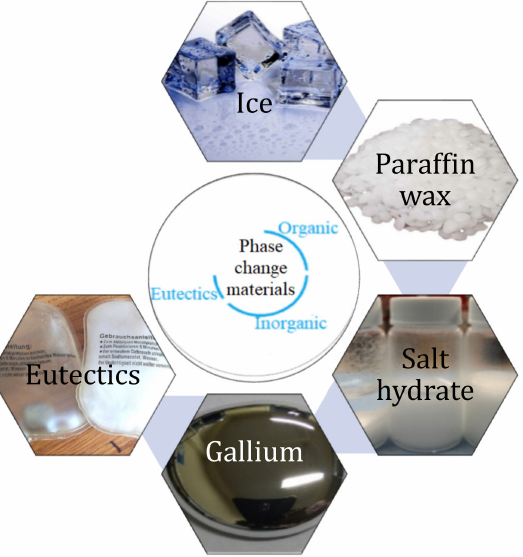
Figure 3. Different types of PCMs, including organic PCMs, such as paraffin wax and ice, inorganic PCMs, such as salt hydrates and gallium, and eutectic